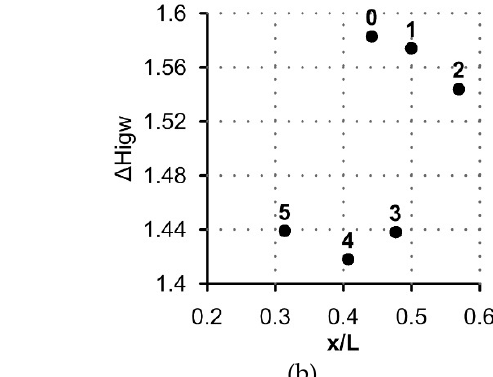
Figure 9. Dependence of ( a ) the shoreline retreat (Sh, m) and ( b ) the relative distance of seaward sediment transport (x/L)over a on relative change in mean wave period ( Δ Tmean, s) occurring during wave transformation over a barred profile (620–820 m, see Figure 4). L is the wavelength calculated for deep-water conditions, x is the distance of the maximal sediments transported away from the shore.